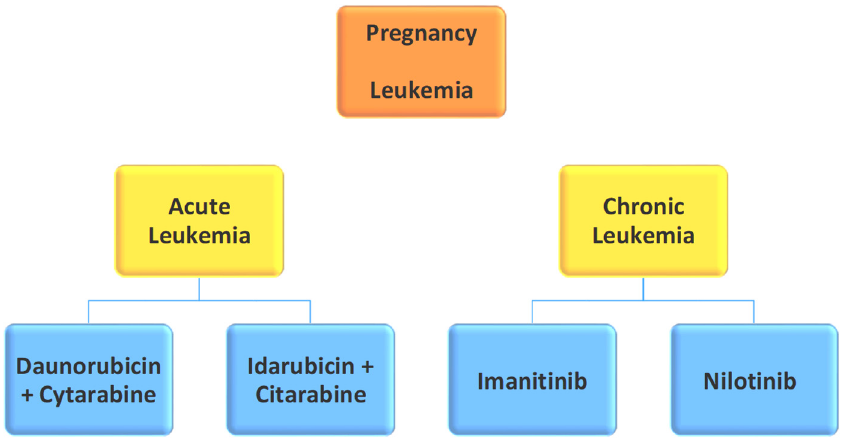
Figure 7 . Pregnancy and Leukemia